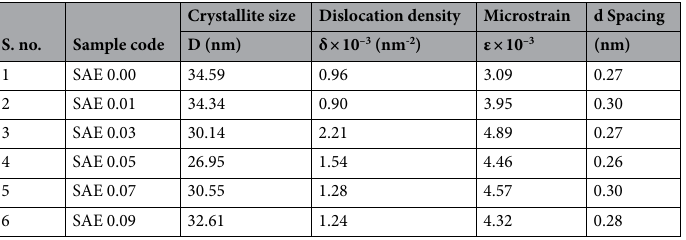
Table 3. Structural parameters—crystallite size D (nm), Dislocation density, Microstrain and Inter-planner spacing d (nm) of Eu 2+ doped Sr 1−x Al 2 O 4 :Eu x (x = 0.00, 0.01, 0.03, 0.05, 0.07, and 0.09) phosphor (SAE phosphor).